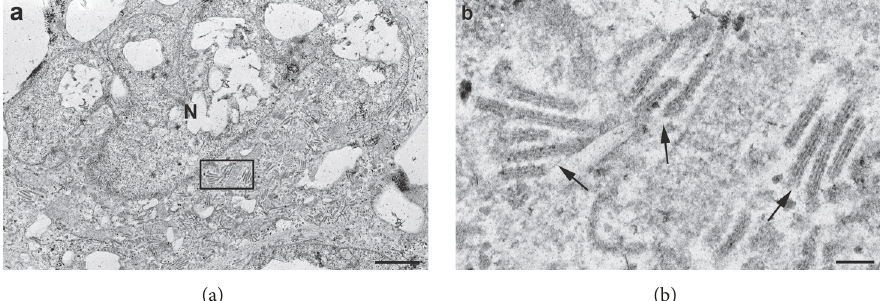
Figure 6: Electron microscopy demonstrates Birbeck granules. Birbeck granules are racquet or rod shaped cell organelles which are a characteristic feature of Langerhans cell. The presence of these on ultrastructural analysis confirms that the cell of origin is from the dendritic cell